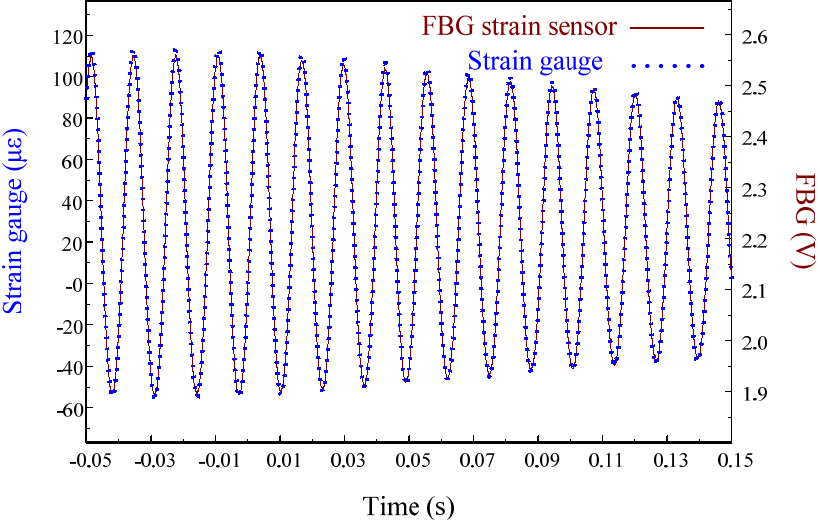
Figure 15. Free vibration of the smart cantilever beam excited at first resonant frequency (76 Hz) with a span of 0.2 s.